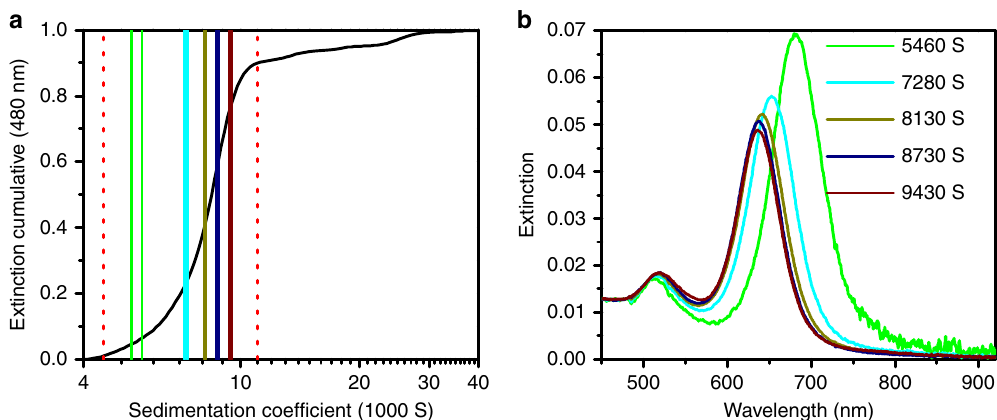
Fig. 4 Acquired sedimentation and spectral data for the fi rst CTAB sample. a Range of analysis (dotted red) and selected sedimentation coef fi cient intervals and b corresponding extracted spectra with mean sedimentation coef fi cients. The color of the intervals corresponds to the upper and lower boundary as well as to the extracted spectra. For reasons of clarity not every spectra or interval is shown. The interval length varies according to the cumulative distribution from 60 to 600 S, the extinction is based on the natural